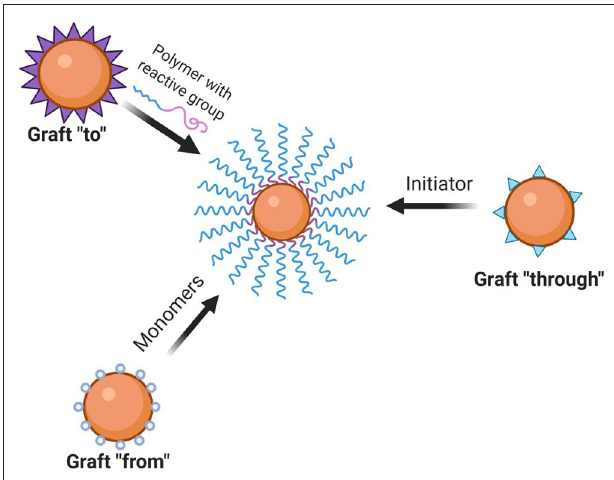
FIGURE 1 | Types of polymer protein conjugation methods (created with